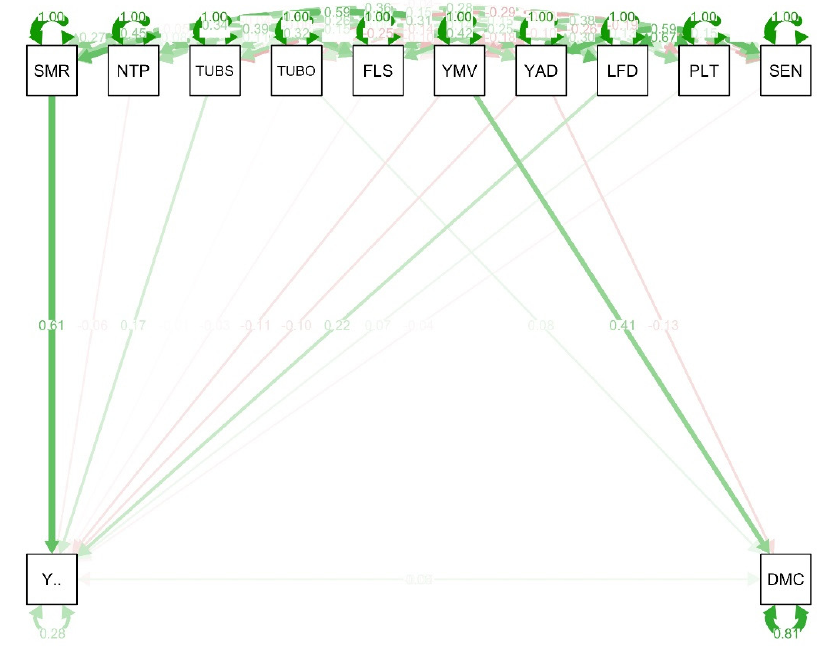
Figure 4. Path coefficient analysis between response and independent yam variables. Y.. = Tuber yield; DMC = Dry matter content; SMR = Sett multiplication ratio; NTP = Number of tubers per plot; TUB = Tuber size; TUBO = Tuber oxidation; FLS = Tuber flesh texture; YMV = Yam mosaic virus disease; YAD = Yam anthracnose disease; LFD = Leaf density; PLT = Plant vigor; SEN = Senescence class. Red indicates direct negative impact, and green indicates direct positive impact.